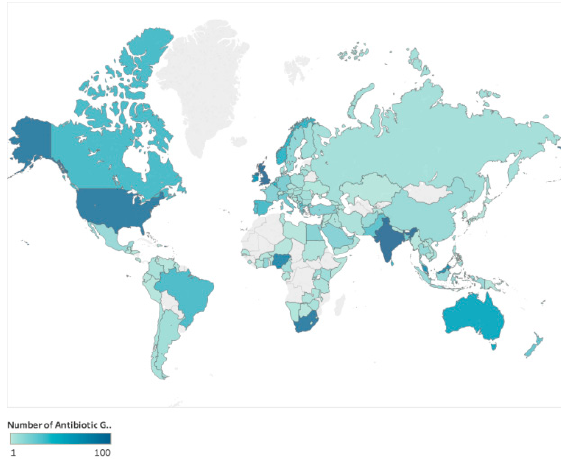
Figure 2. World Map of Antibiotic Guardians (2015–2017).